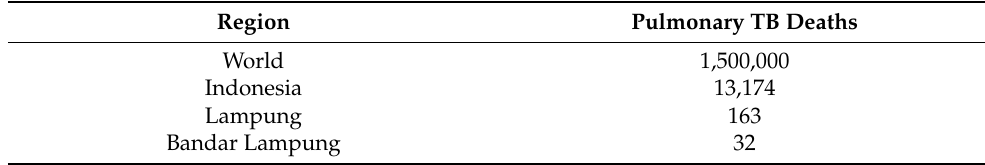
Table A1. Estimated number of pulmonary TB deaths in 2020